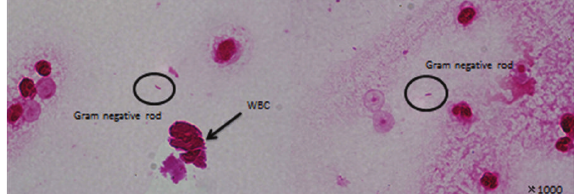
Figure 5: Rapid Gram staining of ascitic fluid. A small number of Gram-negative rods and a large number of leukocytes were seen.